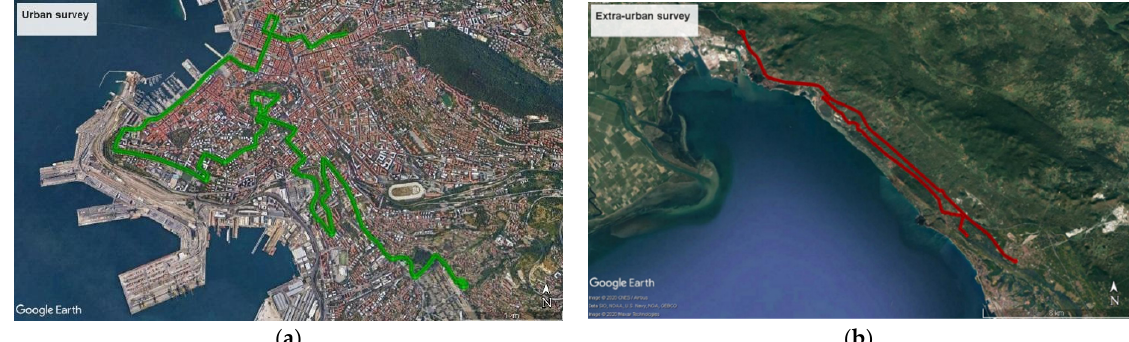
Figure 4. The surveyed area for terrestrial data collection. ( a ) in green, the reference trajectory produced by the Mobile Mapping System Position and Orientation System for Land Vehicles (MMS POS/LV system) in the urban experiment. ( b ) in red, the extra-urban survey. The PCS (POS Computer System) (Applanix, Richmond Hill, ON, Canada) is the central element of the Applanix system: it acquires and processes data coming from the different sensors, providing the positioning and attitude parameters of the vehicles in real time and stores them for subsequent post-processing. The integrated inertial system is a Litton LN-200 fiber optic gyro IMU (Inertial Measurements Unit) (Northrop Grumman, Falls Church, VA, USA)with three accelerometers and three fiber-optic laser gyros (identical with the instrument used for the aerial data-collection campaigns). The odometer uses an optical sensor generating 1024 pulses per revolution. Its function is to estimate the run distance and, above all, to determine when the vehicle has come to a halt (ZUPD, Zero Velocity Update). Two geodetic GPS receivers send the data to the PCS for positioning and direction determination, the latter utilizing the GAMS (GPS Azimuth Measurement Subsystem) (Applanix, Richmond Hill, ON, Canada) software module. Figure 5. The MMS of the GeoSNav Lab, University of Trieste, and the Applanix Corporation POS/LV© system components mounted on board the vehicle. MMS data were used to create the reference trajectory. Table 6. Equipment used in the terrestrial data-collection campaigns. Equipment